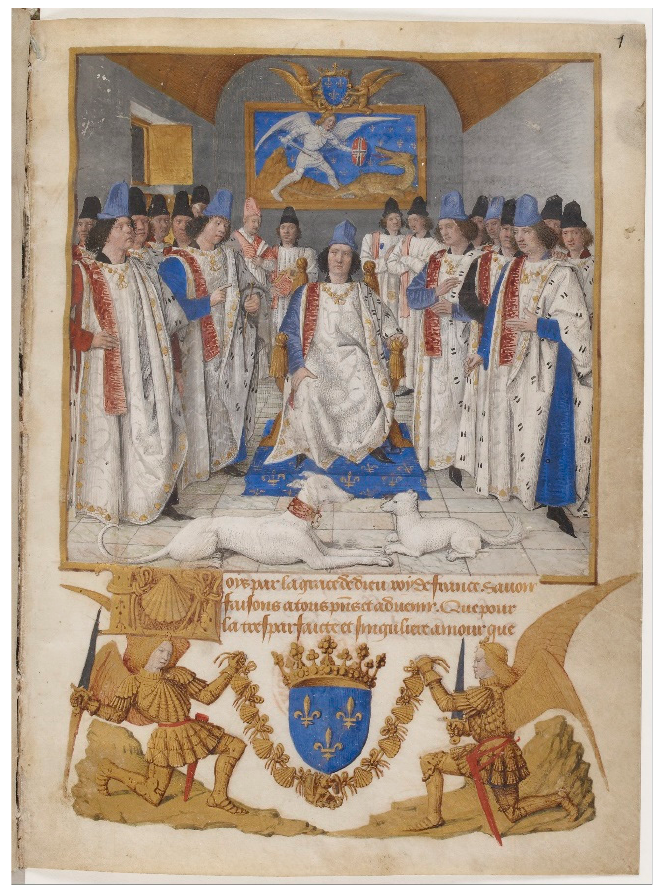
(Figure 5). Fouquet’s illumination places the king at the very centre of the image, wearing the order’s livery and chain of golden scallop shells. He is surrounded by the founding members, and on the wall behind him, above his head, hangs a picture of Saint Michael slaying the dragon. The archangel is dwarfed by the presence of the king. Beneath the illumination, Fouquet painted two angels wearing armour made of scallop shells, holding the chain of the order, above which sits a royal coat of arms topped with a crown. This iconography suggests that the saint, once primarily a holy protector of the kingdom, had morphed through Louis’ patronage into a symbol of loyalty to the powerful monarch. Louis used the imagery of Saint Michael to endorse and legitimise his own political achievements in his expansion of royal territory and to manipulate the aristocracy. He used images of Saint Michael in secular and religious settings to achieve this.